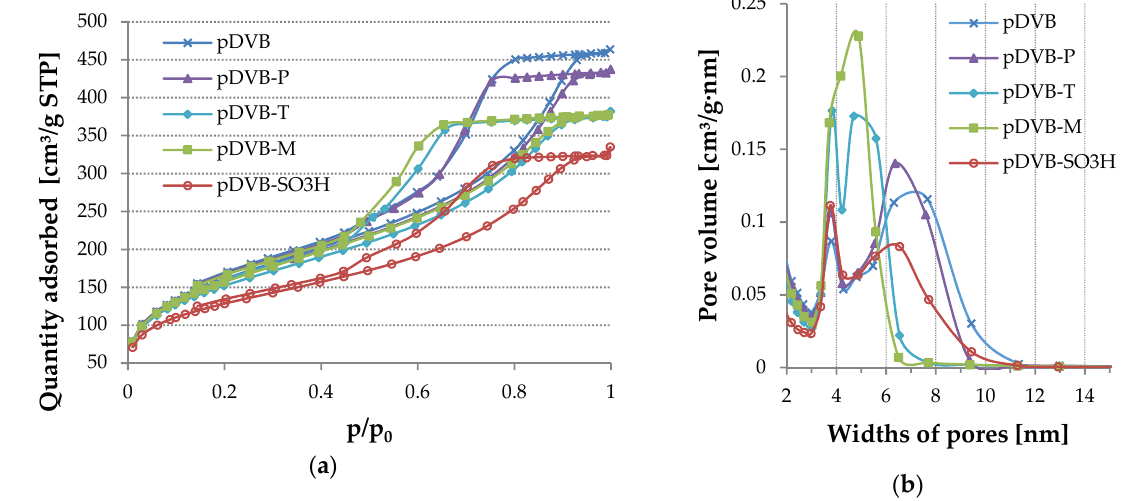
Figure 4. The results of the nitrogen sorption experiments for the studied polymers. ( a ) N 2 adsorption– desorption isotherms; ( b ) Pore size distribution.